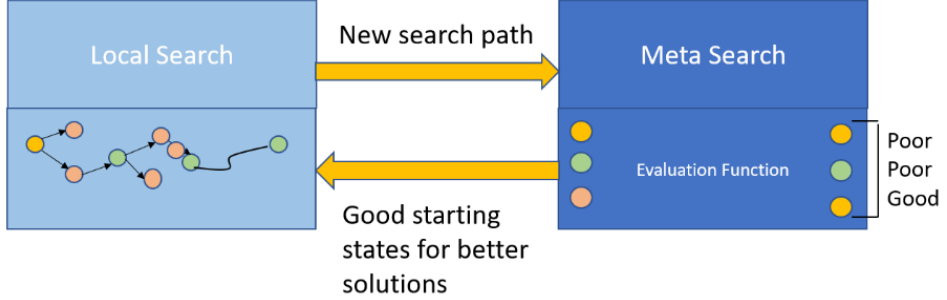
Figure 8. The proposed ML-based MOO method [6].